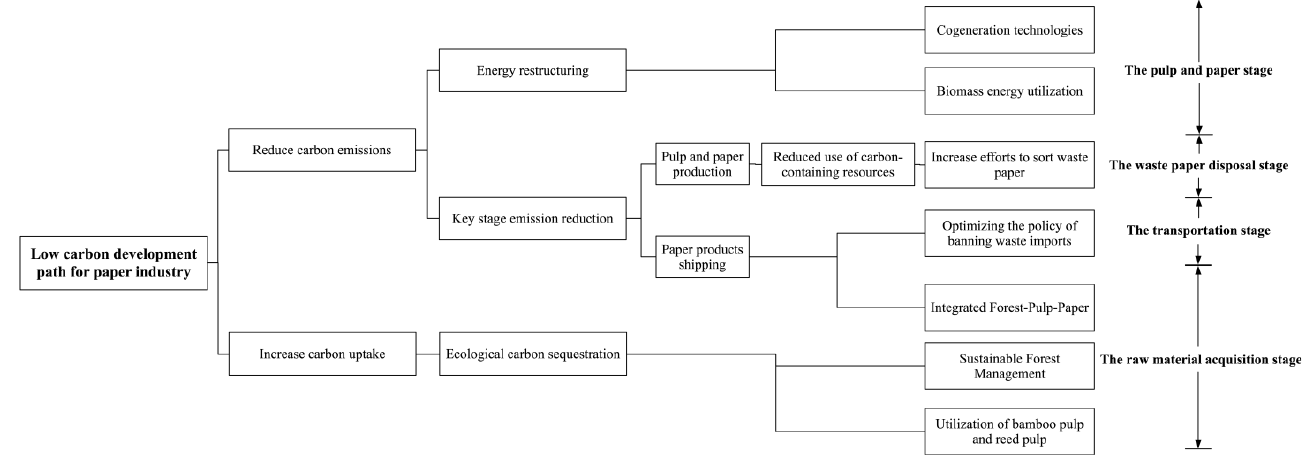
Figure 8. Low carbon development route map for the whole life cycle of papermaking industry.